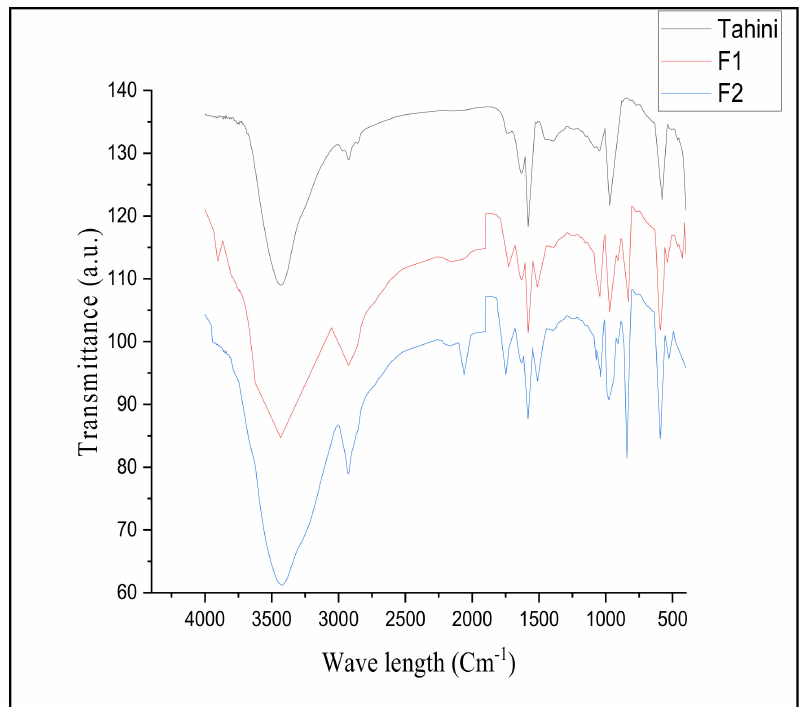
Figure 3. Fourier-transform infrared (FTIR) results for the control and fortified tahini samples. Tahini: the standard sample of tahini manufactured from sesame paste; F1: fortified tahini sample manufactured using 0.5% lyophilized mushroom; F2: fortified tahini sample manufactured using 1.0% lyophilized